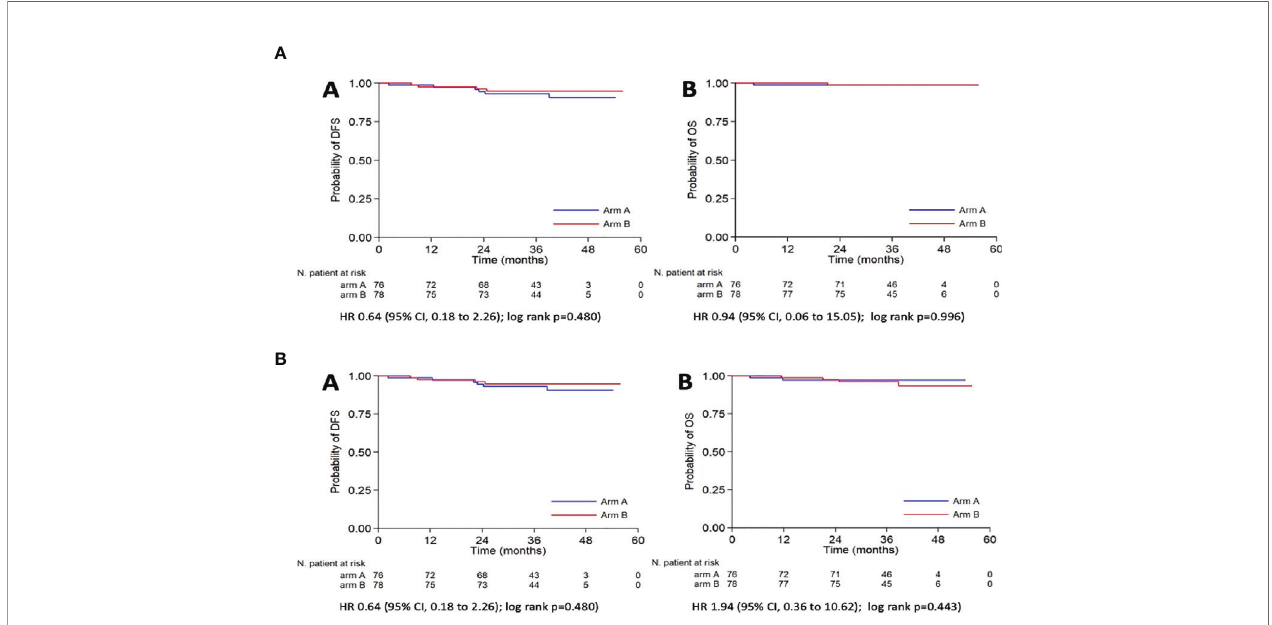
FIGURE 2 | Kaplan-Meier curves for DFS (A) and OS (B) according to the use of IUM. (a) DFS, Disease Free Survival; OS, Overall survival; (b) DFS, Disease Free Survival; OS, Overall survival (death for any cause); IUM, Intrauterine manipulator; HR, Hazard Ratio; CI, Con fi dence